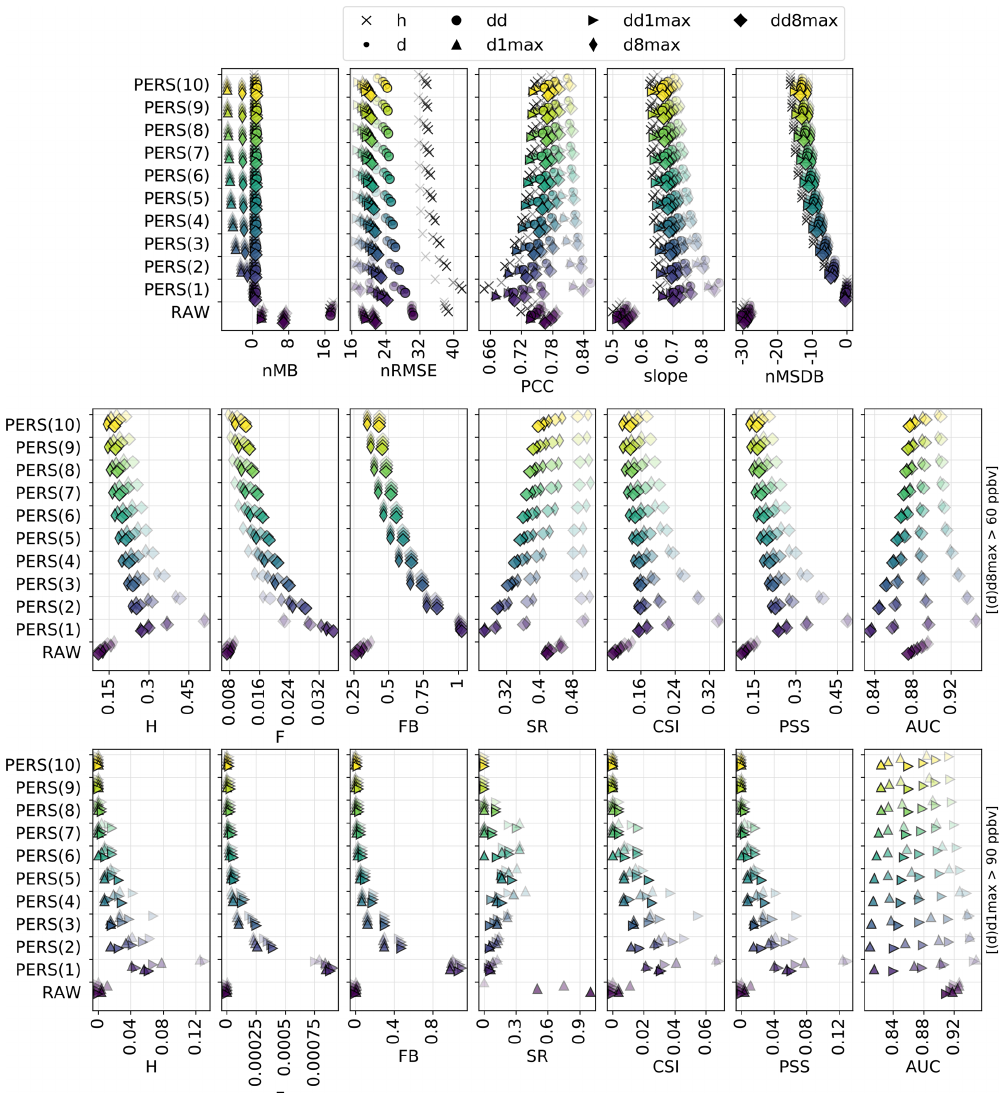
Figure G1. Similar to Fig. 3 for sensitivity tests on the PERS